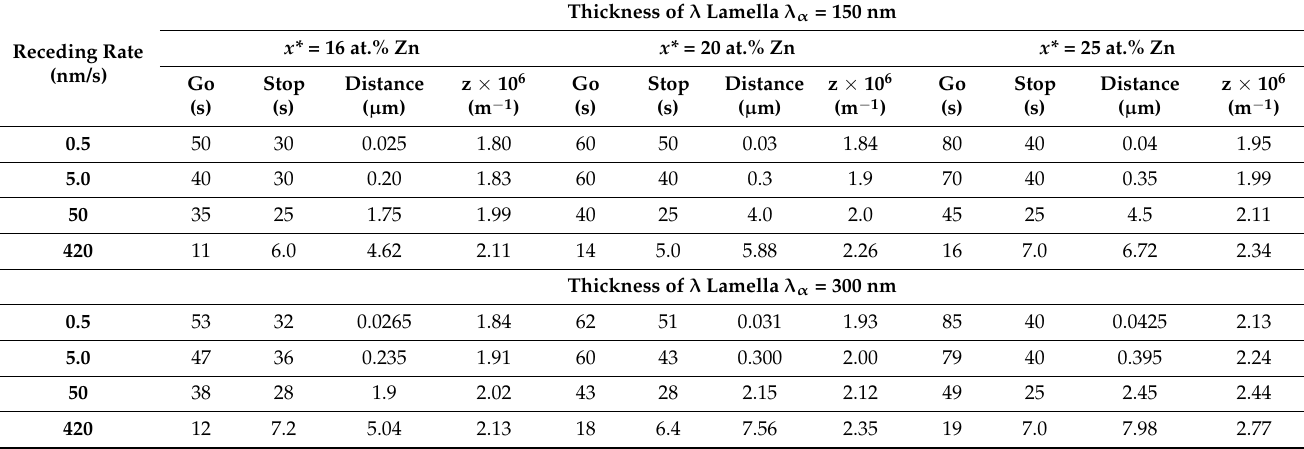
Table 4. Summary of go- and -stop motion for λ α = 150 and 300 nm; v DD = 0.5–420 nm/s; and x * = 16, 20, and 25 at.% Zn. Fe-13.5 at% Zn alloy, C max =